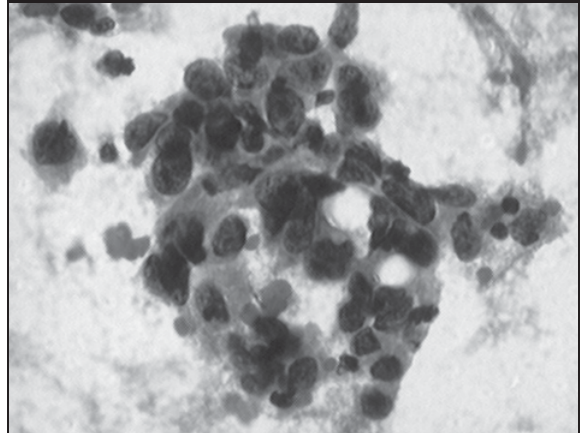
Figura 2 – Grupamento de células neoplásicas formando blocos tridimensionais, com arranjo glanduliforme e pleomorfos, hipercromáticos e de cromatina grosseira (coloração de Papanicolaou,